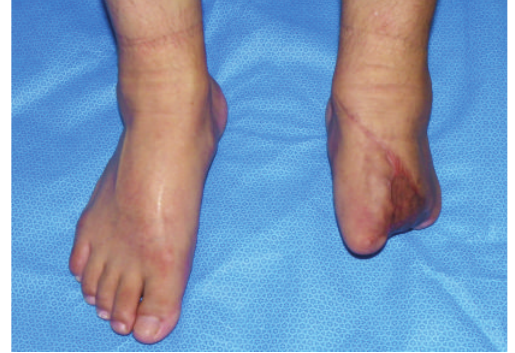
Figure 8: Clinical view at 12 month